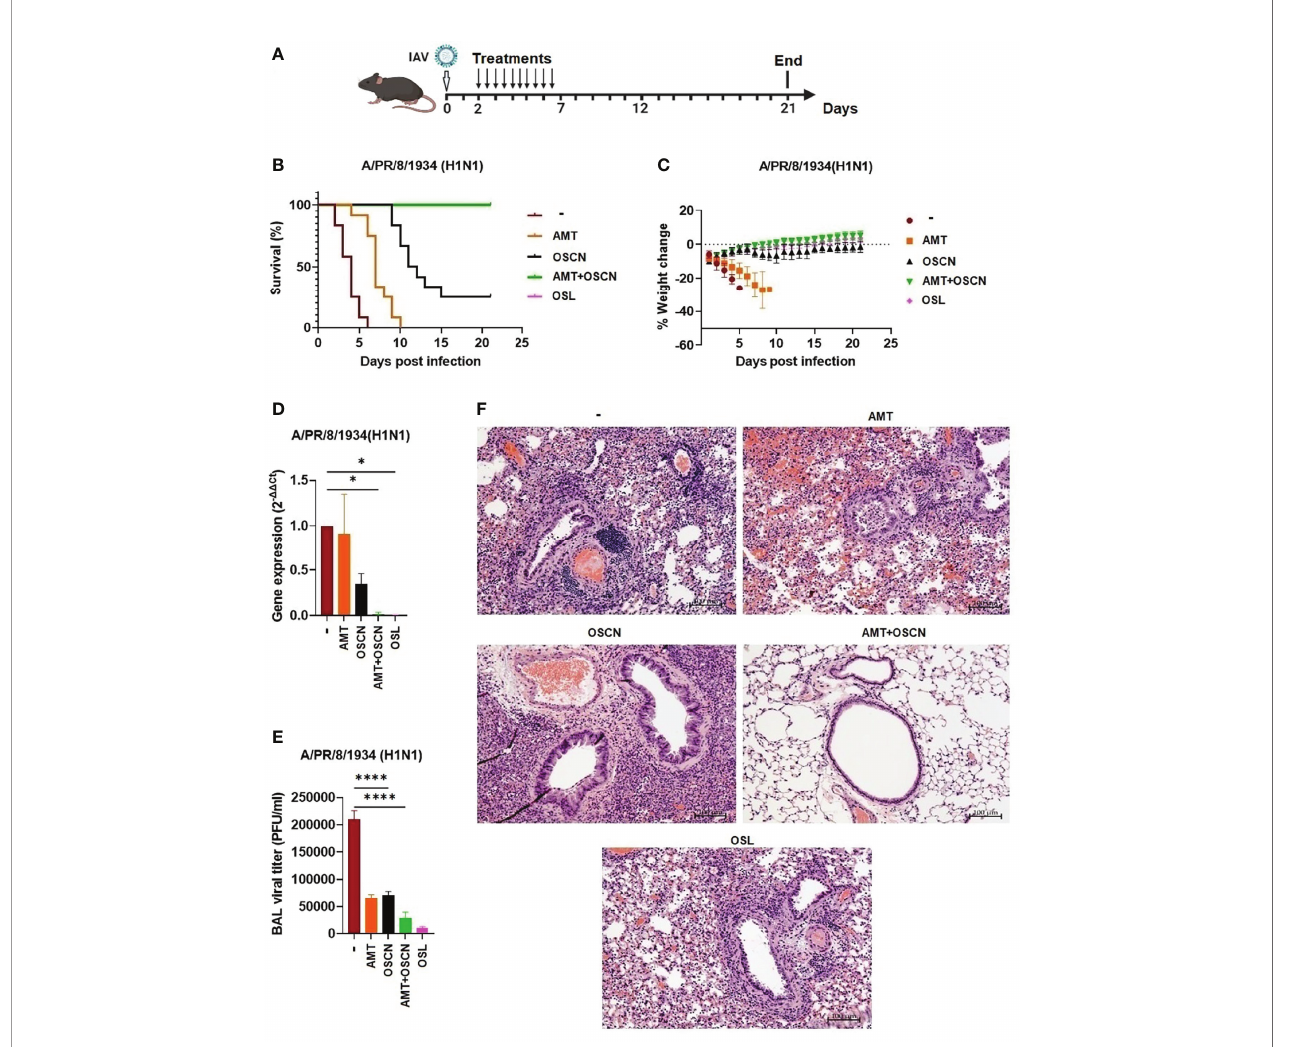
FIGURE 7 | The AMT+OSCN − combination treatment cured mice from lethal H1N1 in fl uenza A virus infection. C57BL/6 mice were infected intranasally with 150 PFU of A/PR/8/34 (H1N1). Mice were treated with the indicated antiviral drugs and their combinations for 5 days (2 – 7 dpi) by oral gavage (two doses daily). In the untreated “ placebo ” group, animals received the equivalent volume of distilled water. Animals were observed until 21 dpi. (A) Experimental scheme. (B) Mortality was measured and presented as Kaplan – Meier survival curves. (C) Weight changes are presented as percentages of the initial body weight of the animals (6 mice per group, two independent experiments). At 3 dpi, BAL from infected mice treated as indicated was collected, and BAL cells and cell-free supernatants were separated by centrifugation. (D) Viral gene expression in BAL cells was measured by qPCR and normalized on the values of the infected but untreated group. (E) Viral titers in cell-free BAL supernatants were determined by PFU assays. Data are expressed as mean ± SEM of n = 3 independent experiments that each used 3 animals per group. (F) Histopathological images of H&E-stained, fi xed lung tissue sections of infected mice treated as indicated (3 dpi). Magni fi cation, ×10; scale bars, 100 m m. AMT, amantadine; BALF, bronchoalveolar lavage fl uid; OSCN − , hypothiocyanite; OSL, oseltamivir; PFU, plaque-forming unit. *, p < 0.05; ****, p <